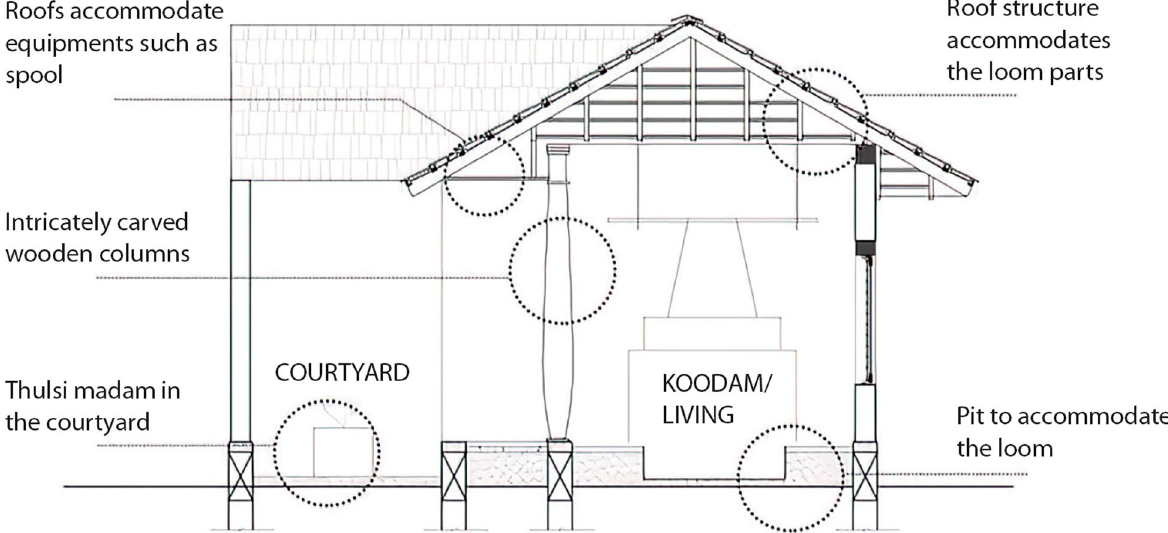
Fig. 14 Section showing the workspace and adjoining courtyard (Source: the